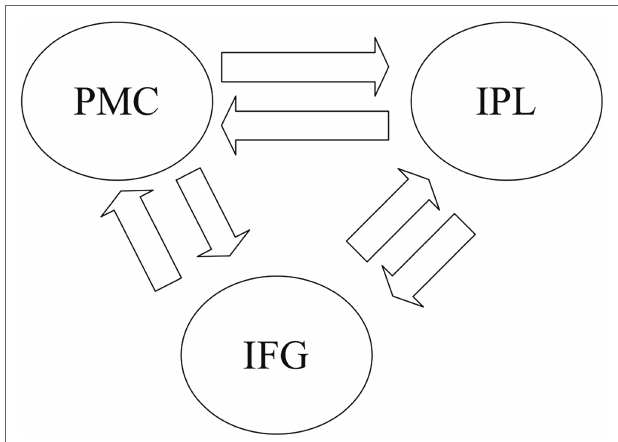
FIGURE 2 | The basic dynamic causal modeling (DCM) model for the DCM across premotor cortex (PMC), inferior frontal gyrus (IFG), and inferior parietal lobule (IPL). The basic DCM model was specified with intrinsic bidirectional connections between all regions of interest (ROIs) and driving input into all Shared sub-regions in the left PMC, IFG, and